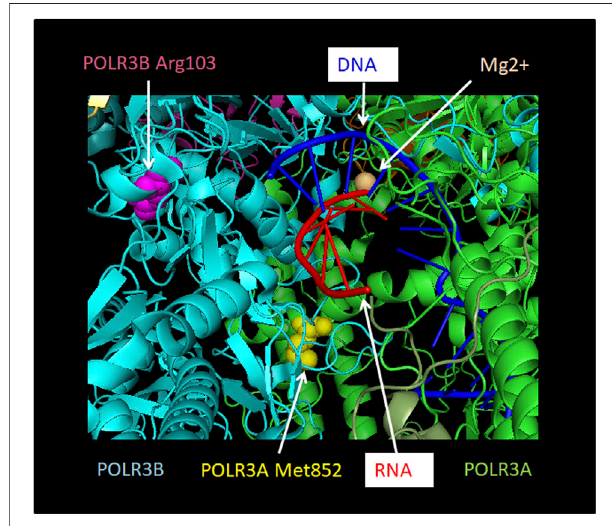
FIGURE 5 | Localization of POLR1C Asn32Ile and Asn74Ser mutations that are associated with POLR3-HLD. Amino acids in POLR1C which cause an assembly defect in Pol III (Thiffault et al., 2015) upon mutation are shown in red (POLR1C Asn32) and in ochre (POLR1C Asn74). They are localized at the interface with Pol III subunits POLR3A (green) and POLR3B (turquoise). The remainder of POLR1C is colored in pink. The Figure was modi fi ed from PDB 7AE3 by employing Pymol.